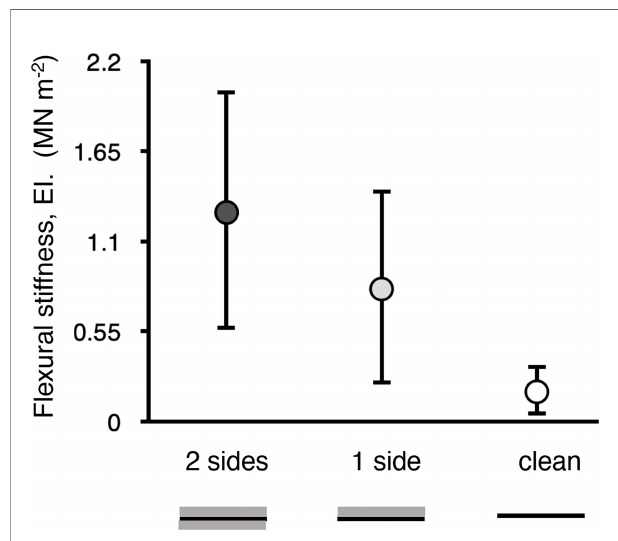
FIGURE 8 | Flexural stiffness (EI) of samples of blades M. splendens with 100% cover of M. membranacea on both the top and bottom surfaces of the blade (2 sides) or on just the top surface (1 side), and of blades with no fouling (clean). Error bars represent one standard deviation (n = 7). The EI of a region of an algal blade with bryozoans growing on both sides was signi fi cantly greater than that of a clean blade (p < 0.01, one-way ANOVA followed by Tukey HSD test, F = 8.45 2,18 ), whereas the EI of a region of blade with bryozoans growing on only one side was not signi fi cantly different from 2 sides or clean (p >